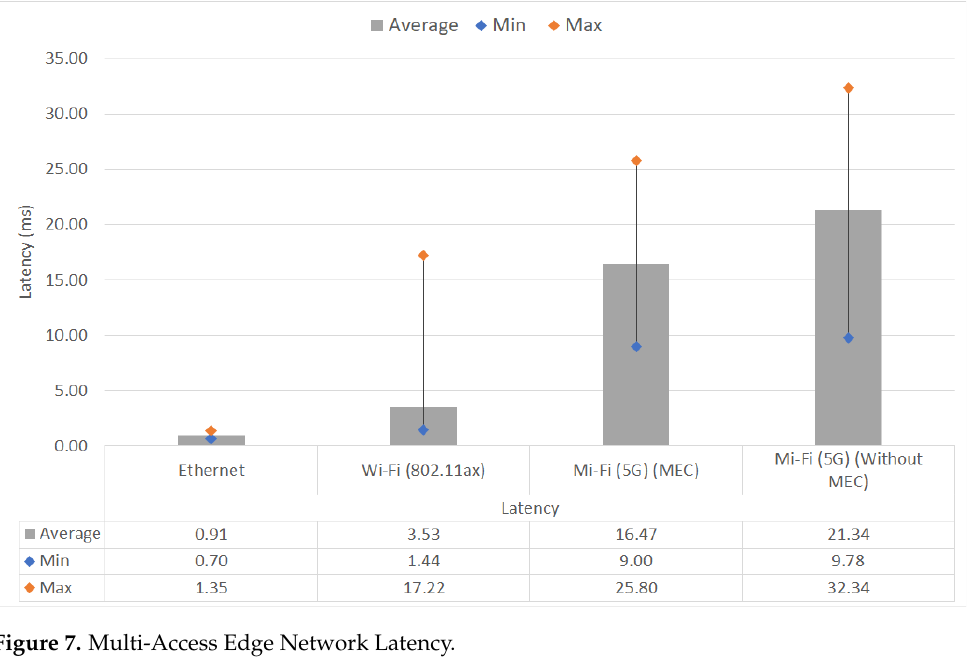
Figure 6. Multi-Access Edge Network Throughput.